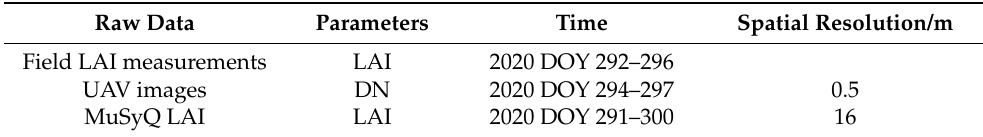
Table 1. The acquisition time (day of year, DOY) and spatial resolutions for field LAI measurements, UAV images and MuSyQ LAI